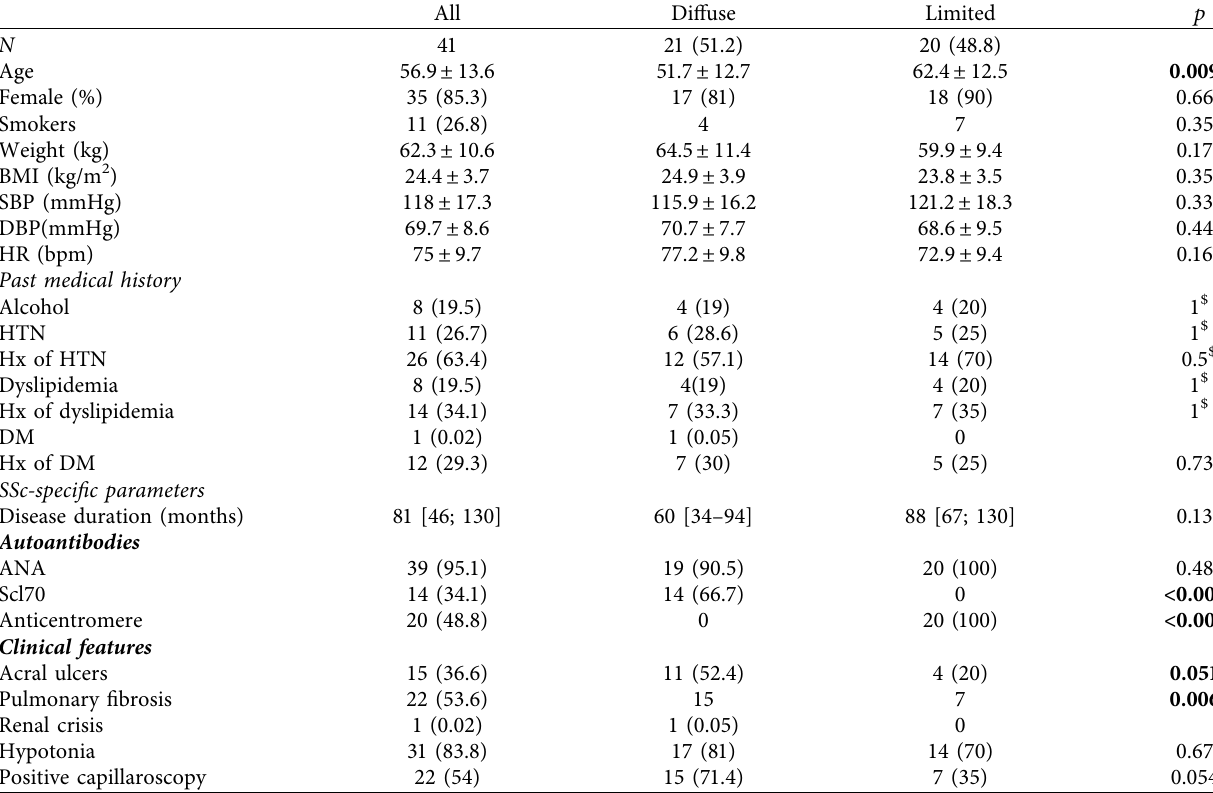
Table 1: Clinical characteristics of the SSc study